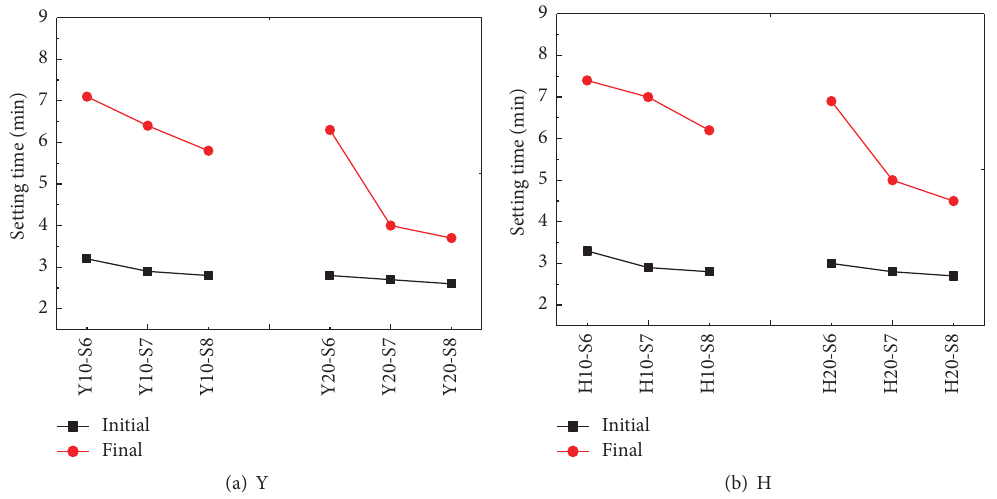
Figure 1: Effect of setting time of cement in addition to HLSA at 10 ∘ C and 20 ∘ C.